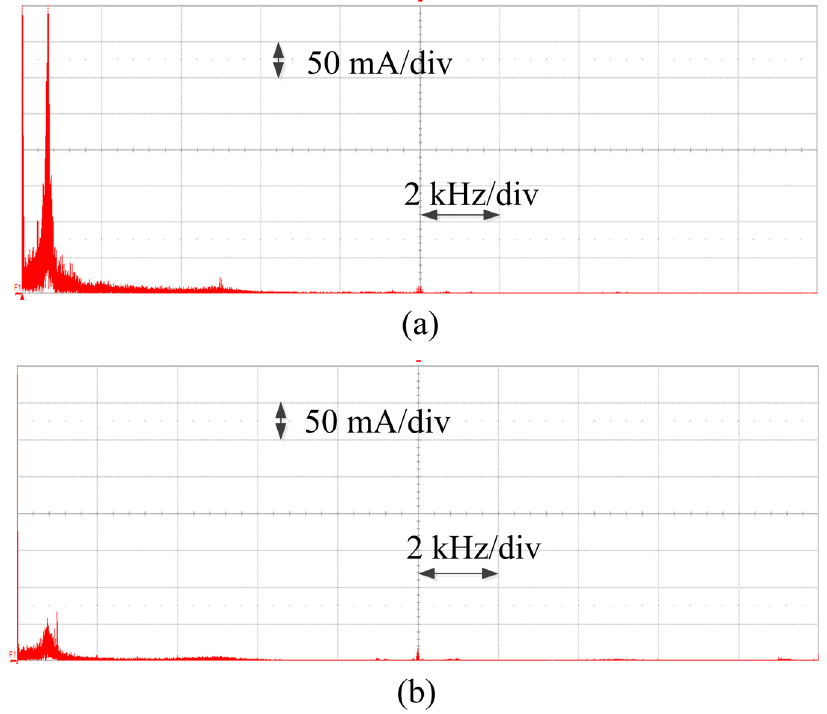
Figure 10. Experimental results of the frequency spectra of the A-phase motor current. ( a ) Conventional FS-PTC; ( b ) proposed PTC-DSVM.